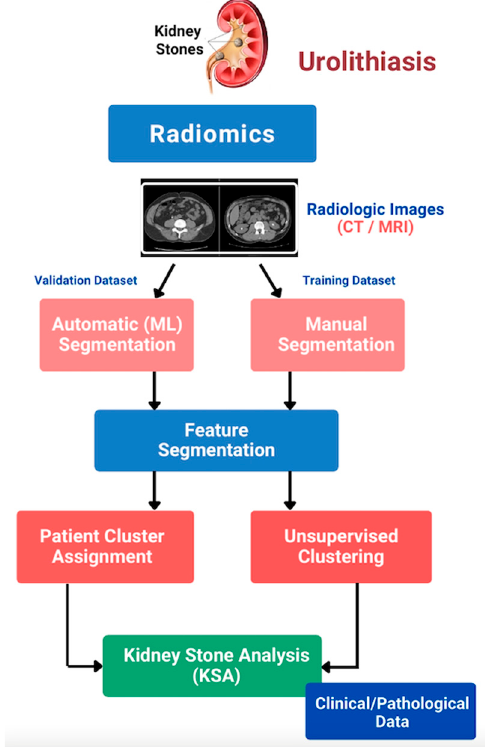
Figure 2. Radiomics approach in the treatment of patients with kidney stone disease.